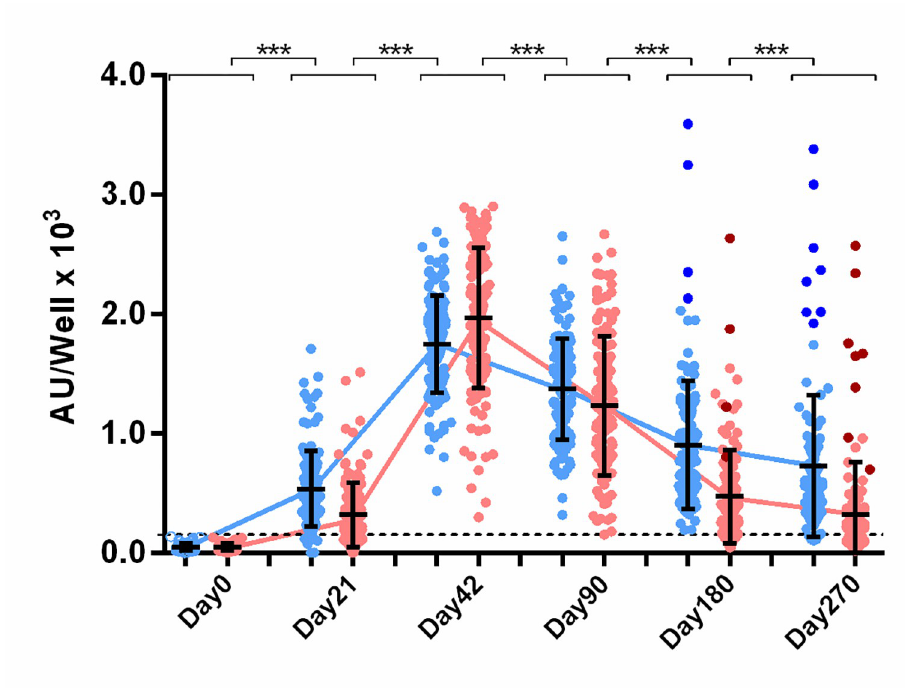
Fig 3. IgG anti-S and anti-RBD levels post-vaccination. Anti-S (blue) and anti-RBD (red) Abs were measured on Day 0, 21, 42, 90, 180 and 270 days after the first dose on Day0. Cut-off values for anti-S and anti-RBD Abs were 150 AU/well (dashed line). Dark colored dots represent post-vaccination infected individual’s anti-S and anti-RBD IgG levels respectively. Asterisks ( ��� ) indicate statistically significant differences ( p -value < 0.001) between the compared groups. Each dot represents an individual, and error bars represent the mean value and standard deviation of the